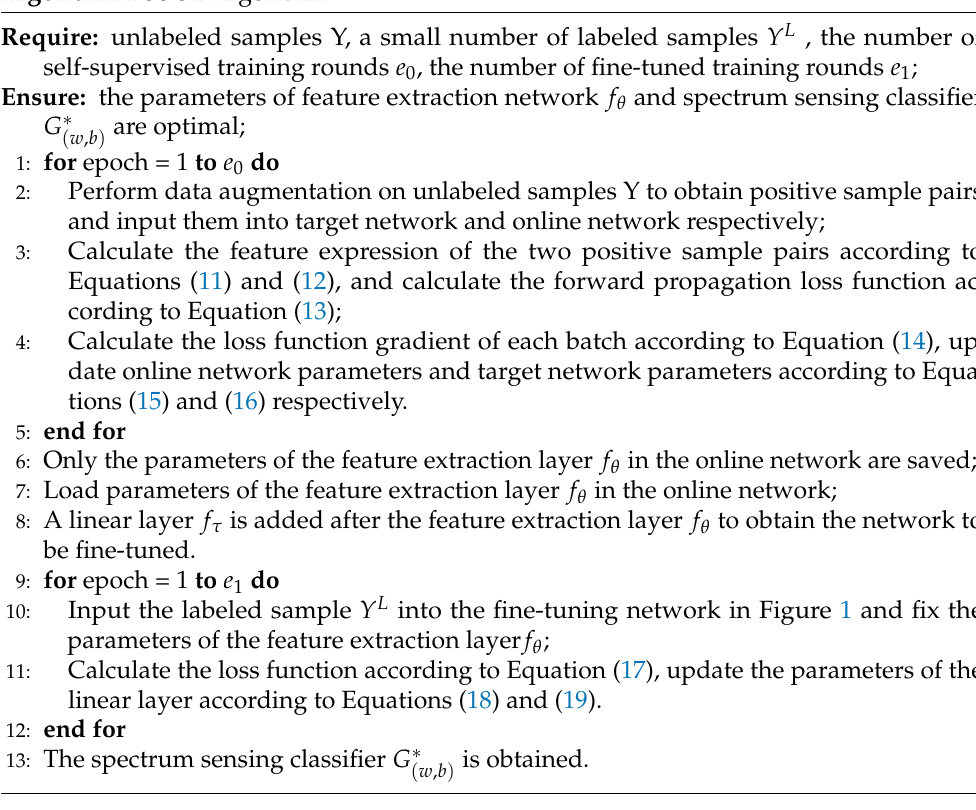
Algorithm 1 SSCL